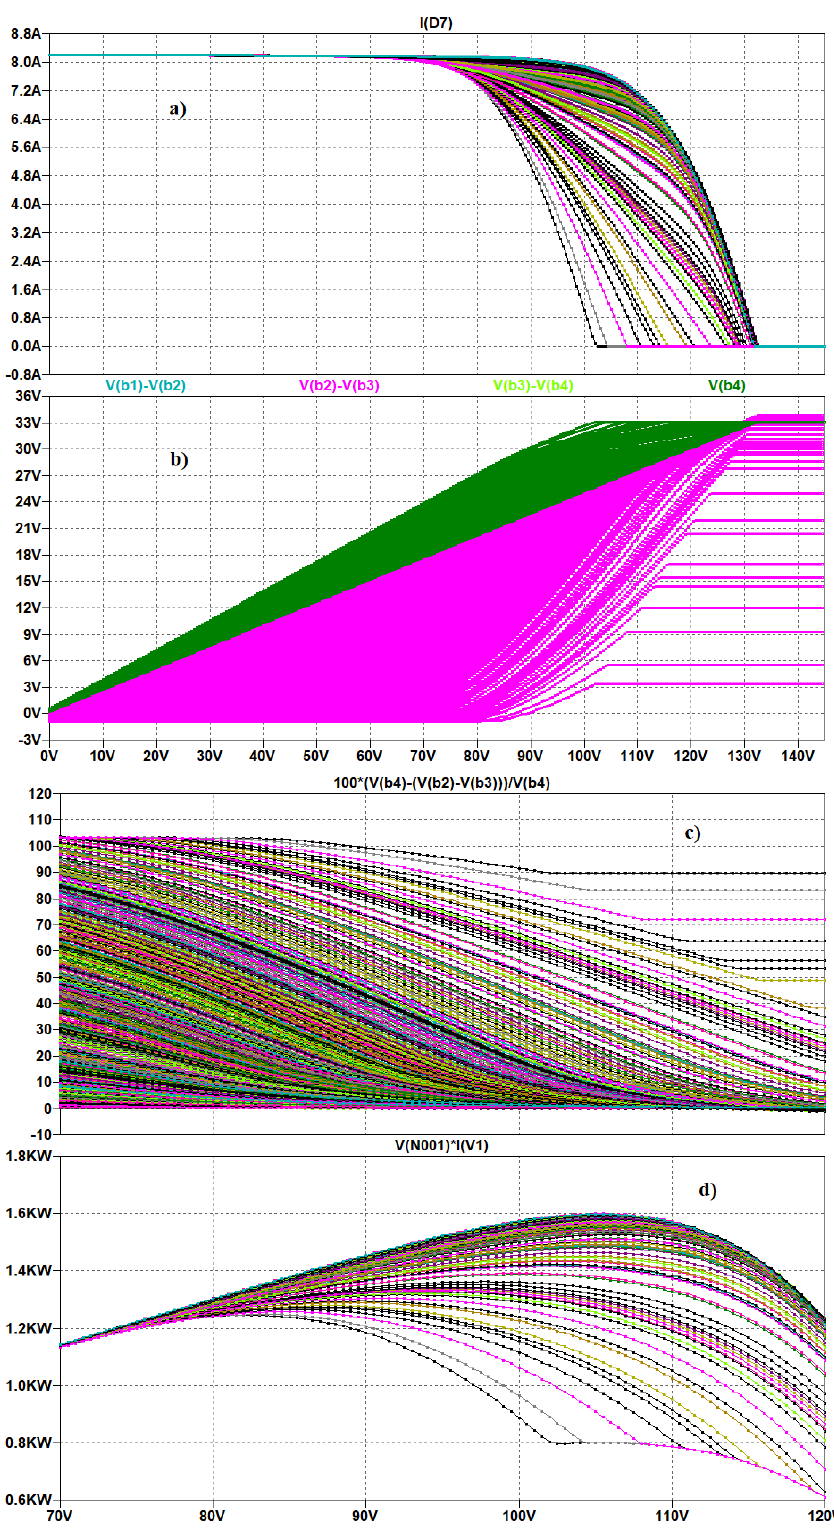
Figure A4. Potential induced degradation faults type 2. This figure shows four charts as following: ( a ) the current of the affected string versus the operation voltage of the array, ( b ) the differential voltage for all the modules in the affected string, ( c ) the relative percentage difference versus the operating voltage of the array, ( d ) peak behavior of output power in the